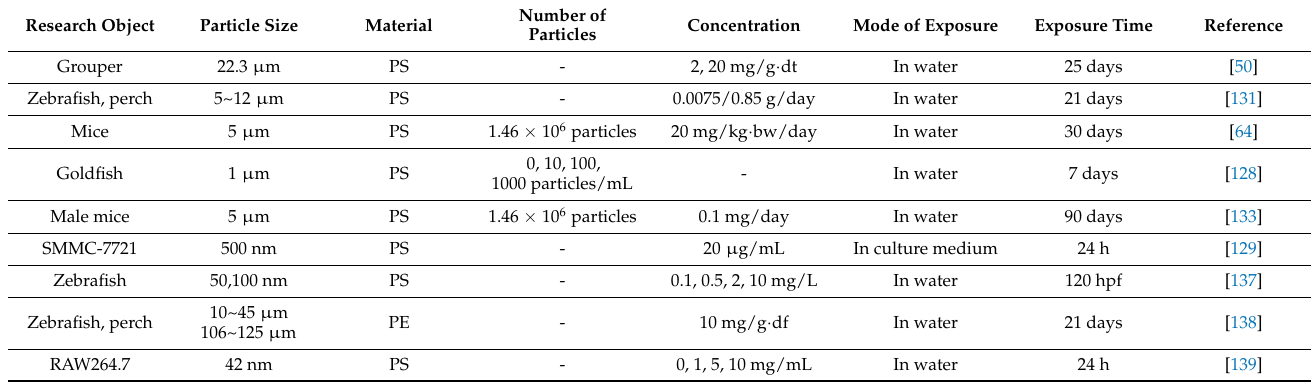
Table 8. The study parameters of MPs and NPs in liver